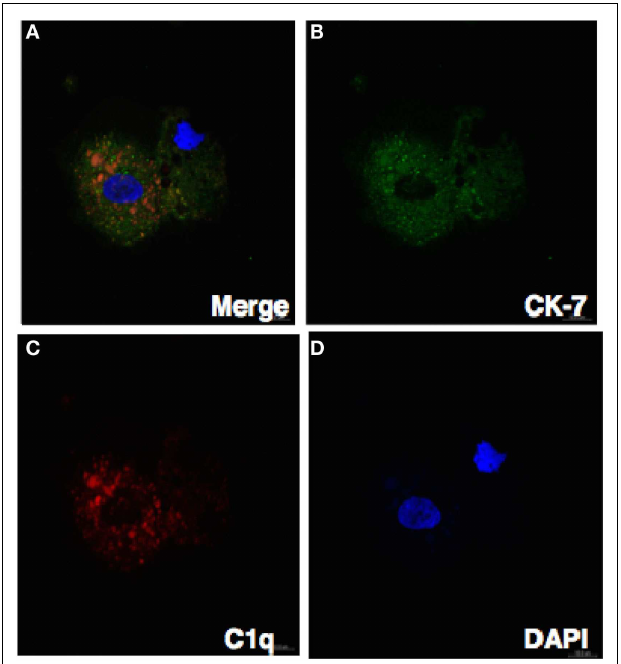
FIGURE 7 | Confocal image showing the trophoblast expressing C1q . Decidual cells cytospun were fixed, permeabilized, immunostained with mouse anti-human CK-7 and goat-anti-human C1q antibodies, and then probed with donkey anti-mouse FITC and donkey anti-goat Cy3 conjugates, counterstained with DAPI and analyzed by confocal microscope (A–D) . Original magnification 60 × oil immersion.